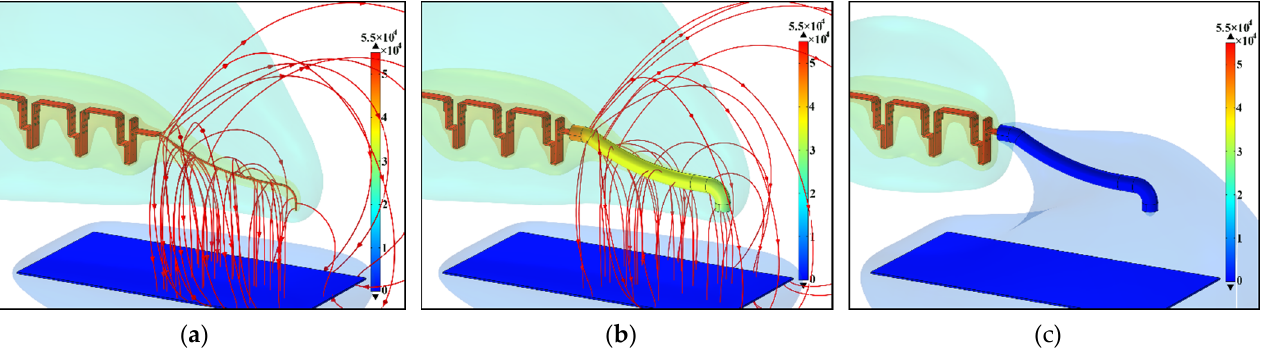
Figure 8. The effect of shielding the test cable: ( a ) initial state of the test cable; ( b ) test cable passed through an aluminum tube; ( c ) test cable passed through a grounded aluminum tube.